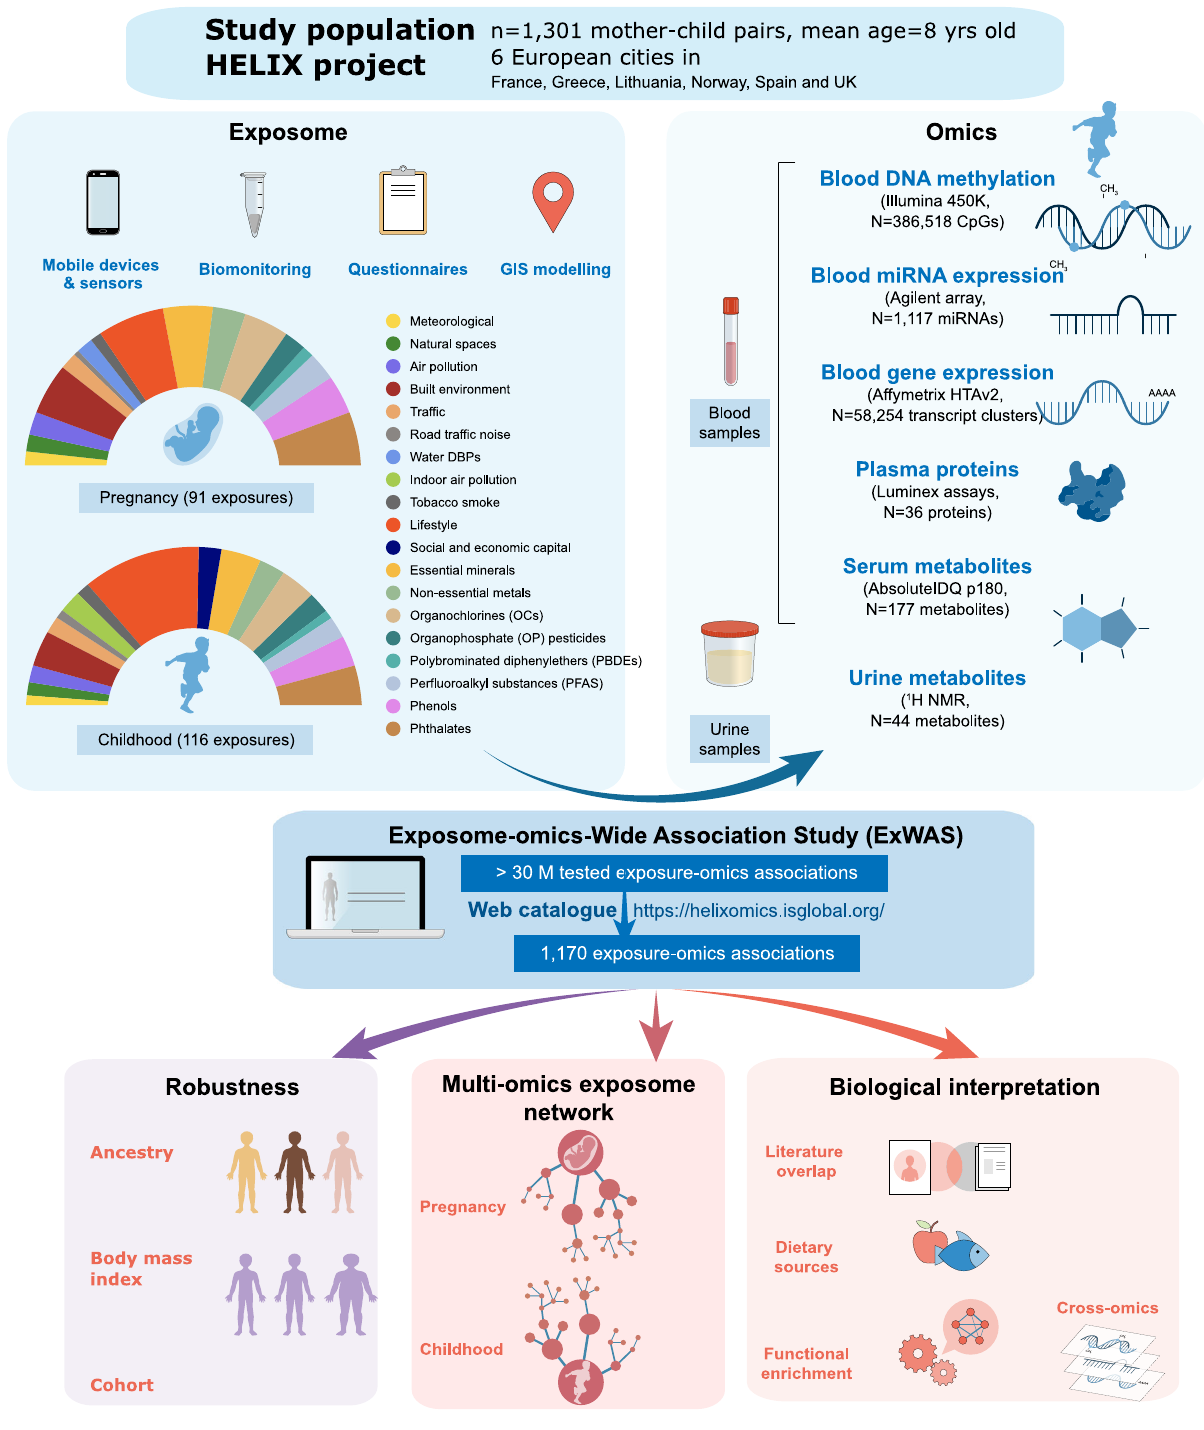
Fig.1|Anoverviewoftheearly-lifeexposomeandmulti-omicssignaturestudy. One thousand three hundred and one mother – child pairs from the HELIX project participated in the study. The early-life exposome was assessed in pregnancy and childhood through the use of different methods. The pie charts represent the proportionofexposuresassessedperexposurefamily.Moleculartraitsinthechild weremeasuredusingsixdifferentomicsplatformsusingblood(bloodcells,serum or plasma) or urine. Then, an Exposome-omics-Wide Association Study (ExWAS) was conducted, modelling exposure-omics one by one and adjusting for